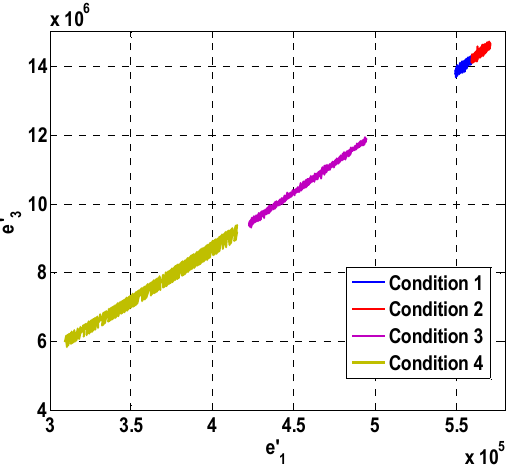
Figure 26. Dynamic error comparison plan map of each actual experimental state e Ten of the 500 captured signal points for each of the four states are listed in Table 1. The data in